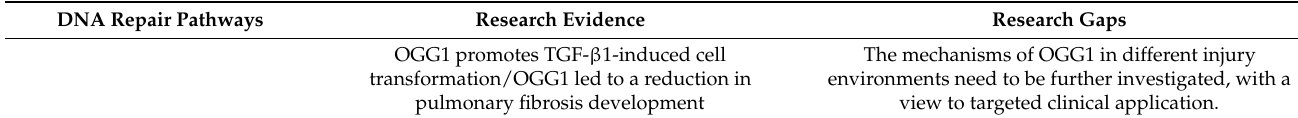
Table 1. A summary of the evidence and research gaps in DNA repair and pulmonary